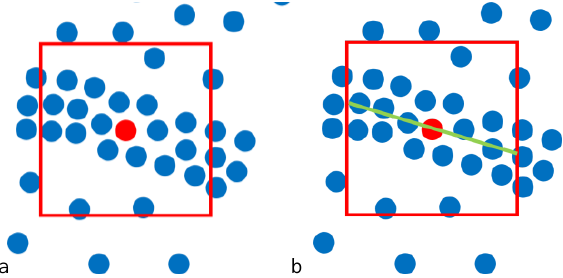
Figure 3. Linearity definition at a defined scale: (a) the selection of the “seed” point (red dot) and nearby points for the defined scale (red square), and (b) the fitted line